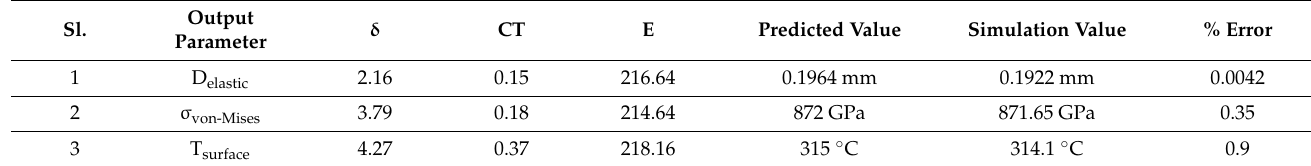
Table 8. Optimum model validation under optimized